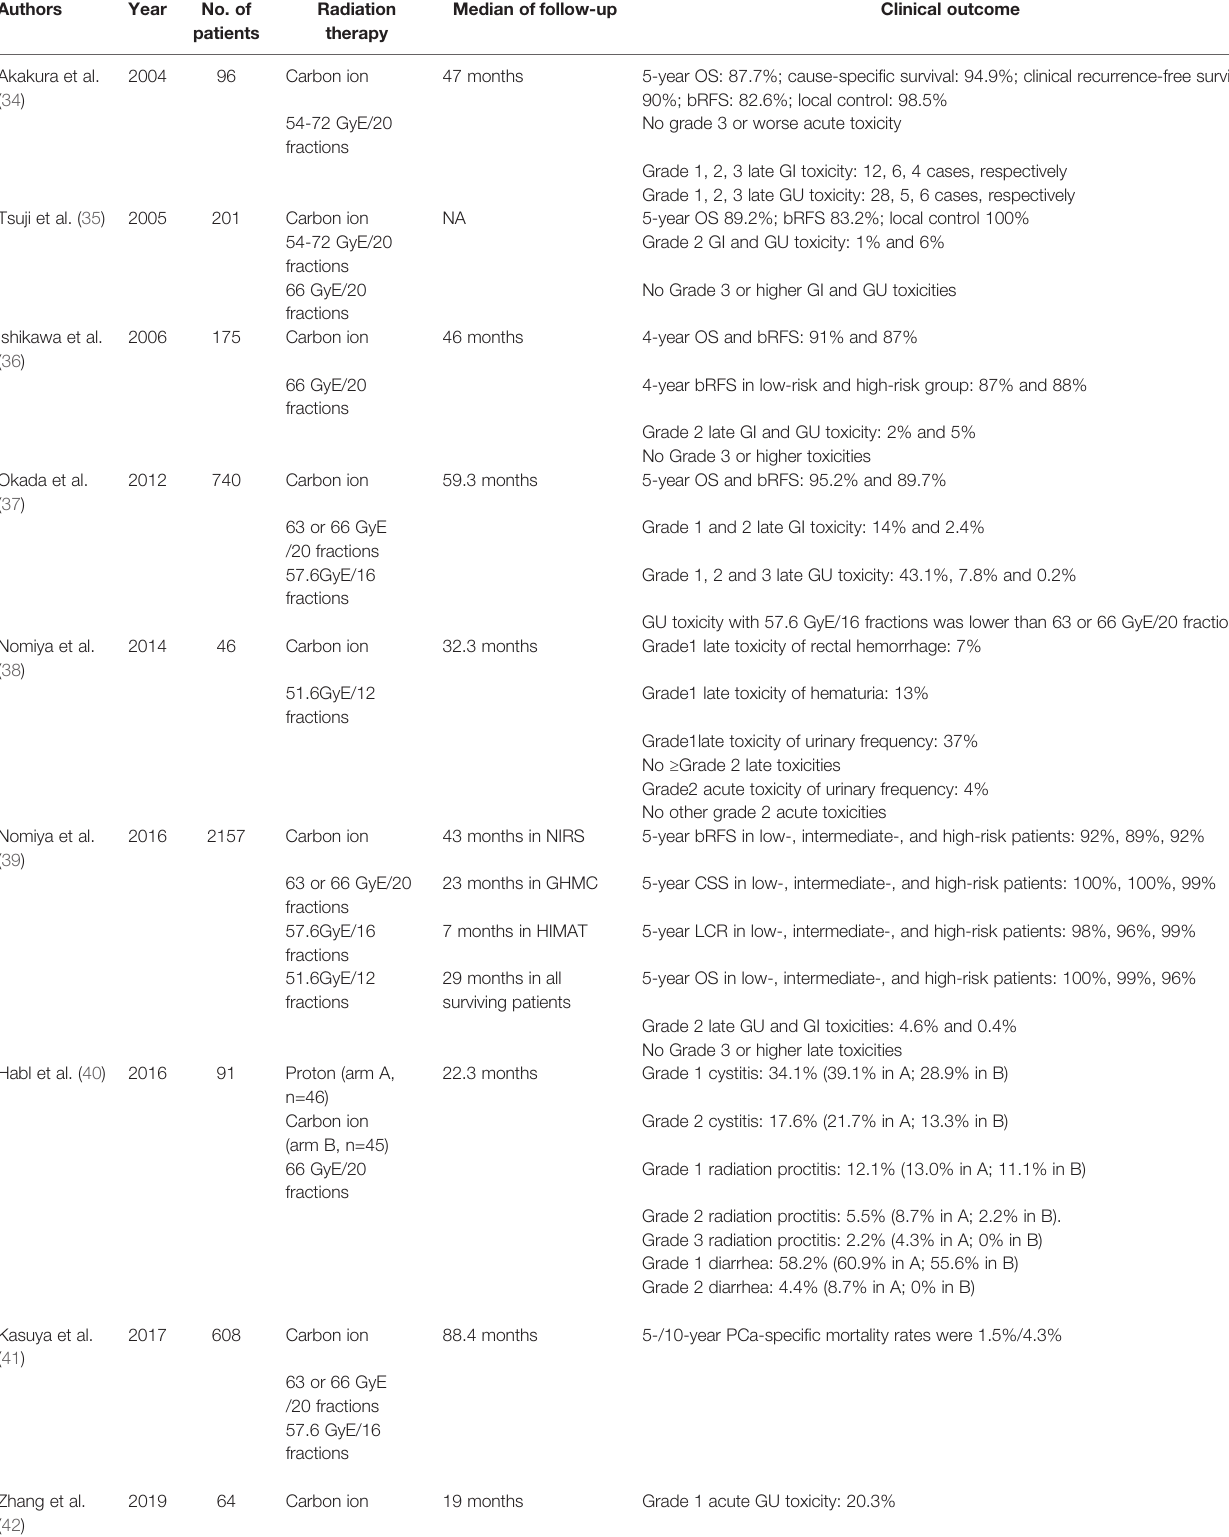
TABLE 3 | Clinical outcome in prostate cancer patients treated with carbon ion